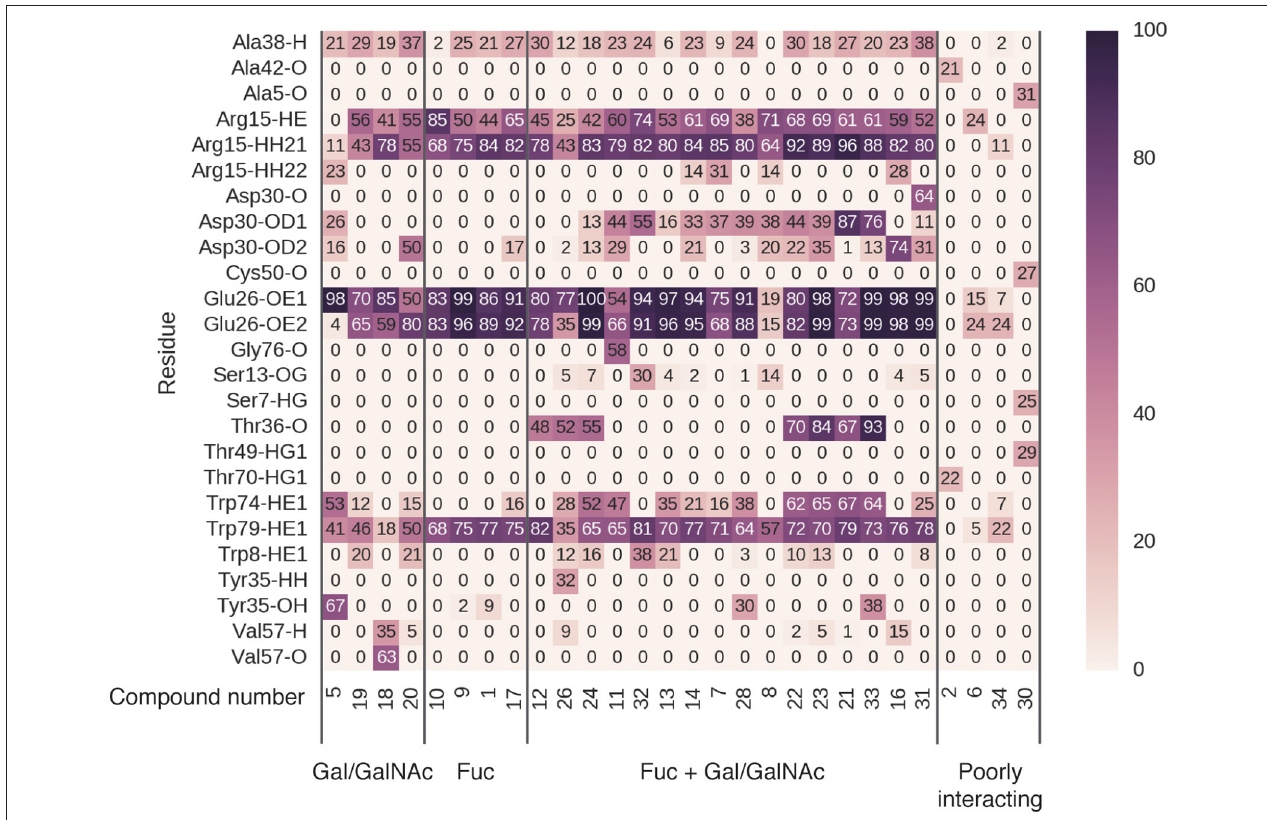
FIGURE 8 | Hydrogen bonding occupancy of blood-group-related saccharides during MD simulations. Saccharide names indicate the ligand moieties interacting with BambL during